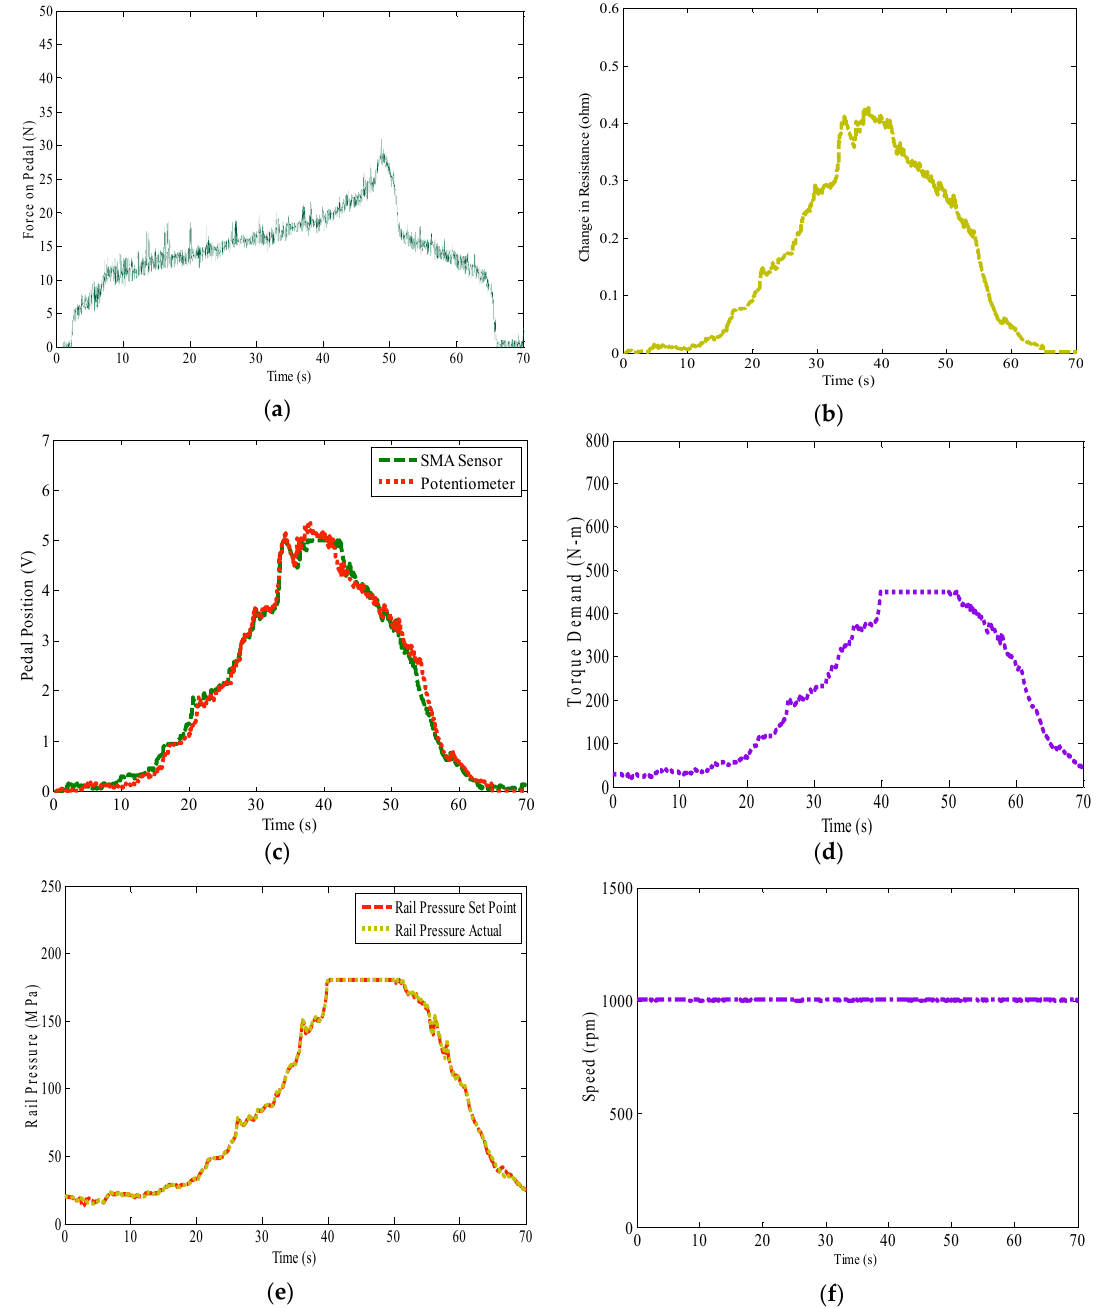
Figure 12. Test results of rail pressure regulation on common rail diesel system by the sensaptics; ( a ) force acting on AAP, ( b ) electrical resistance variation in SMA, ( c ) sensing signal of sensaptics as APP, ( d ) torque demand, ( e ) rail pressure— desired and actual, ( f ) test speed.